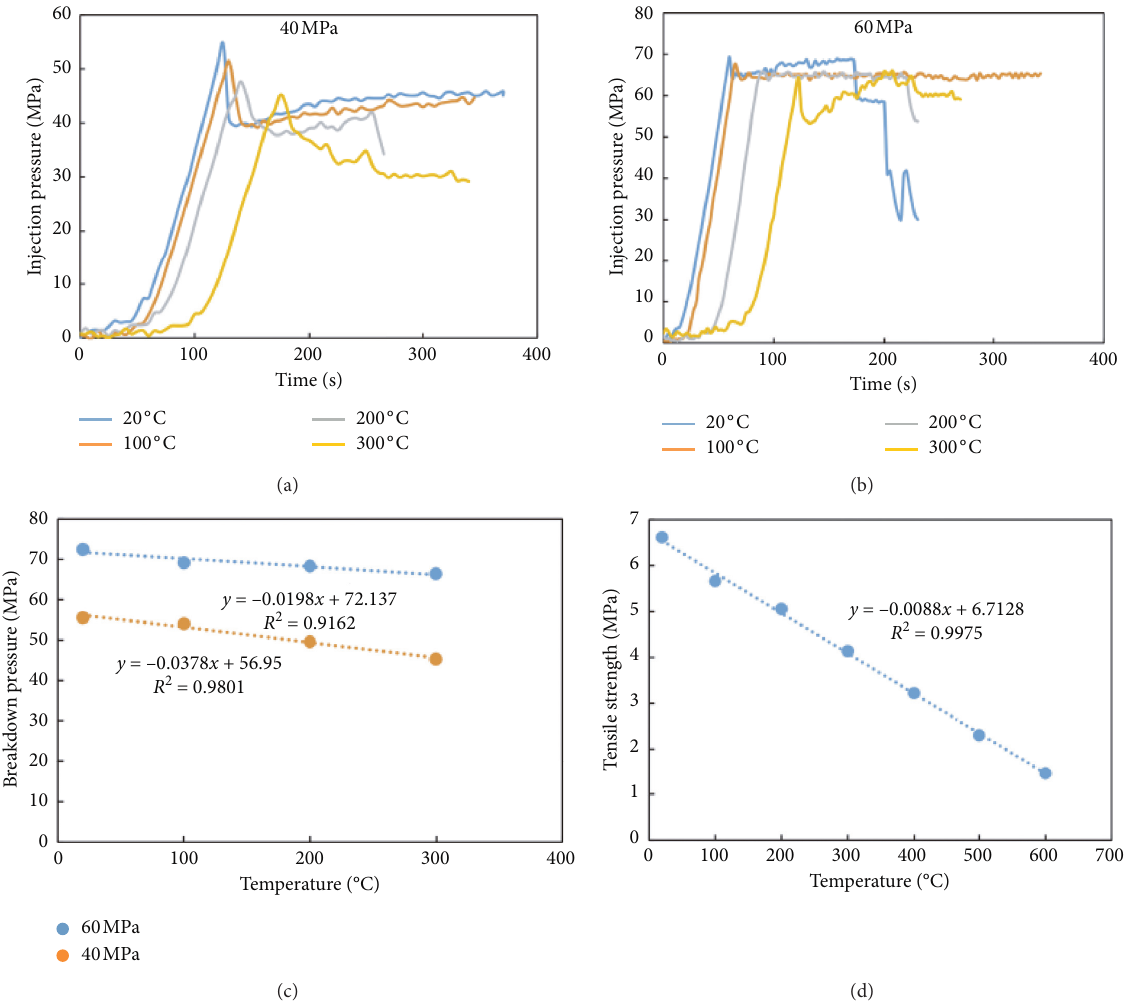
Figure 7: Temperature effect on the hydraulic fracturing behavior and tensile strength of Harcourt granite [44]. (a) Injection pressure-time curves at 40MPa confining pressure. (b) Injection-time curves at 60 MPa confining pressure. (c) Breakdown pressure-temperature curves. (d) Tensile strength-temperature curve.